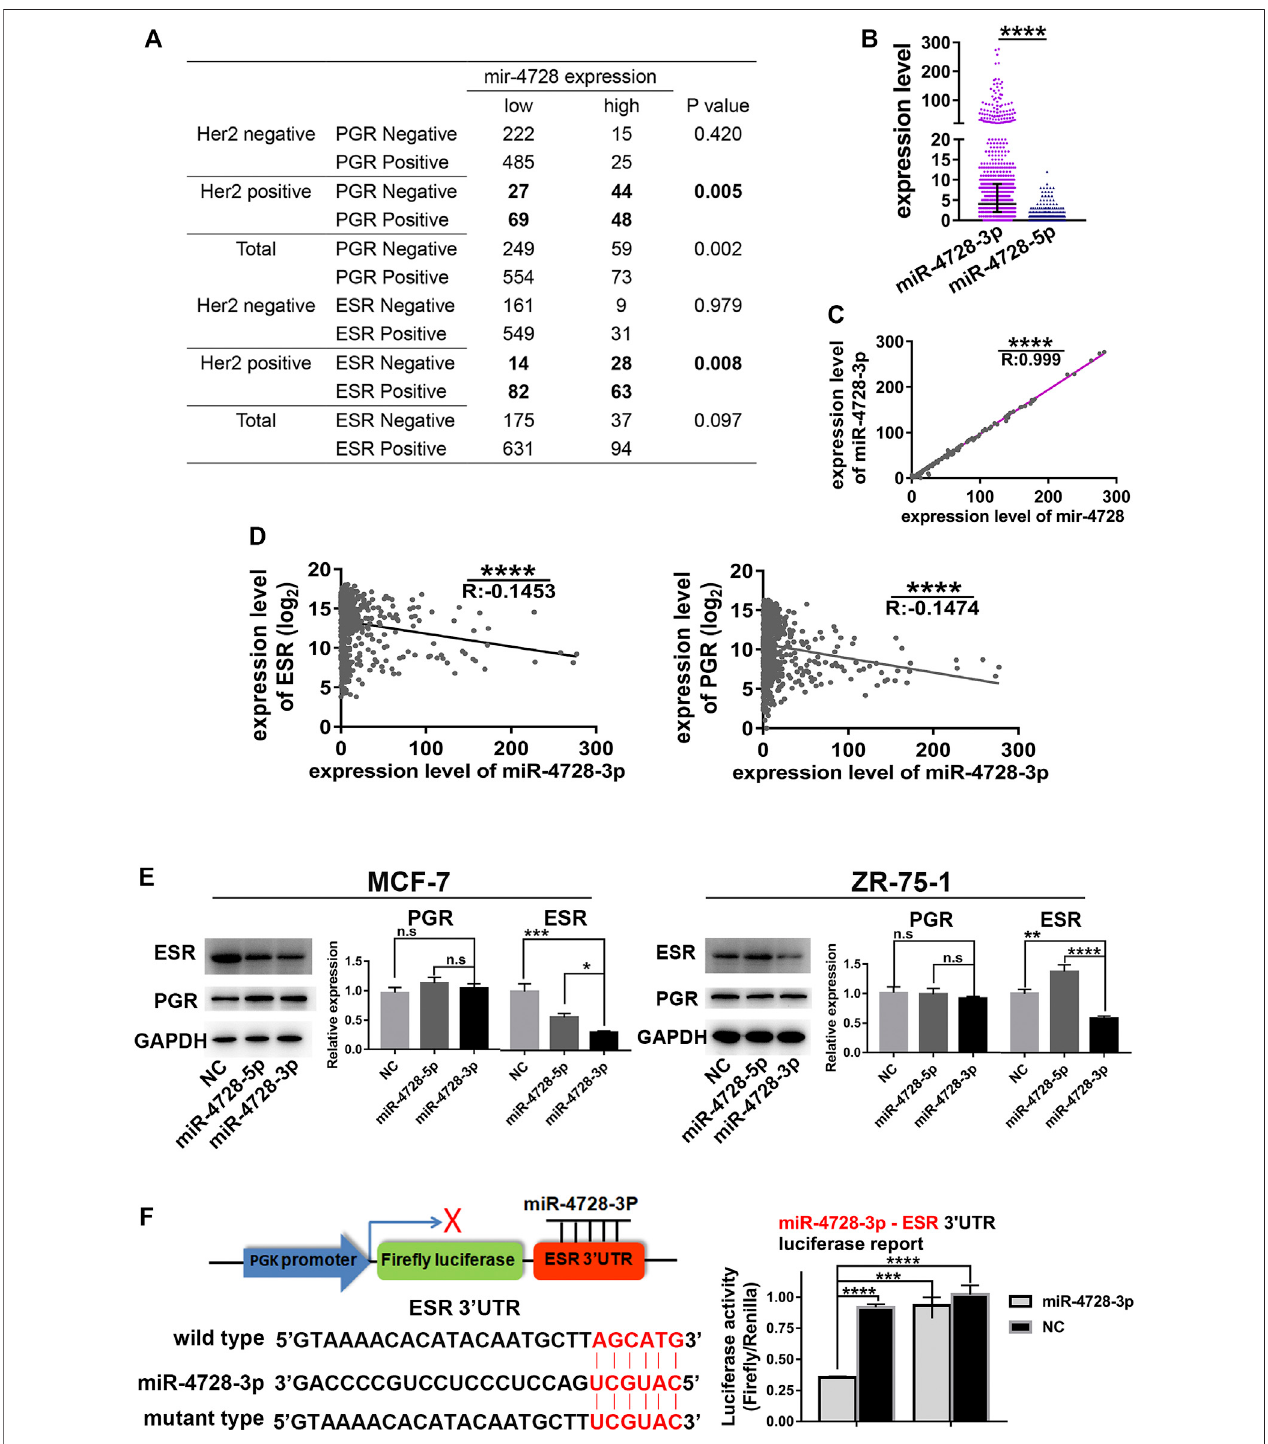
FIGURE 3 | MiR-4728-3p, spliced from mir-4728, directly targets the expression of ESR. (A) Correlation analysis between the expression of mir-4728 and ESR or PGR in the patients with different HER2 statuses. (B) The expression of miR-4728-3p and miR-4728-5p in breast cancer. (C) Linear correlation analysis between the expression ofmir-4728and miR-4728-3p. (D) Linear correlation analysisbetweentheexpression ofmiR-4728-3p and ESR(left)orPGR(right). (E) Westernblotdetects the change of ESR and PGR expression under the control of miR-4728-3p, miR-4728-5p, or the controls. (F) Dual-Luciferase assay shows the relative luciferase activities (Fire fl y/Renilla) among the 293T cells co-transfected with miR-4728-3p or controls and wild-type or mutant-type Dual-Luciferase reporters.